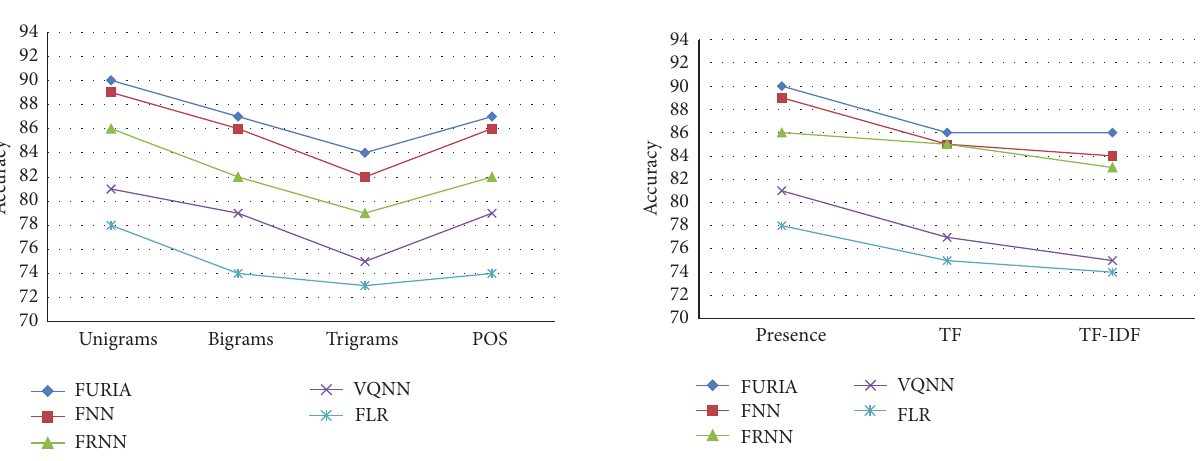
Figure 6: Classifiers performance with different feature methods on restaurants dataset.